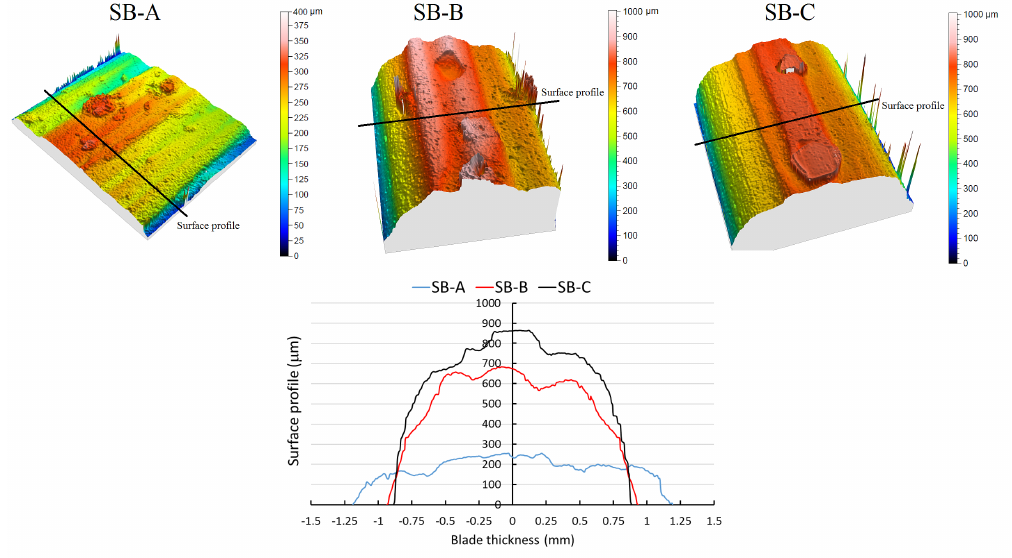
Figure 5. Surface topography of the edge of the segment area for each type of